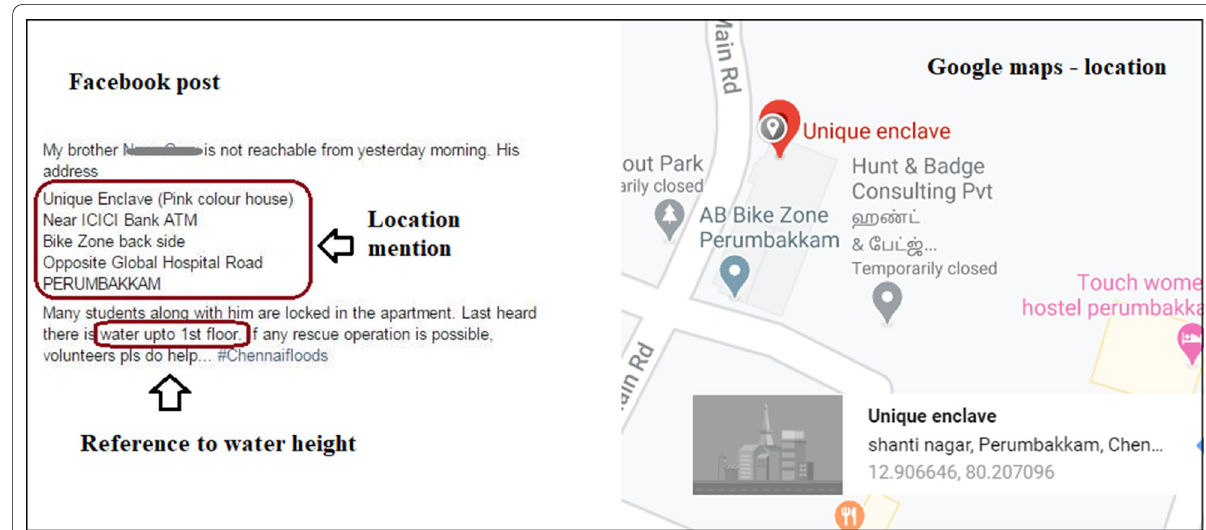
Fig. 3 Example message with location and water height mentions